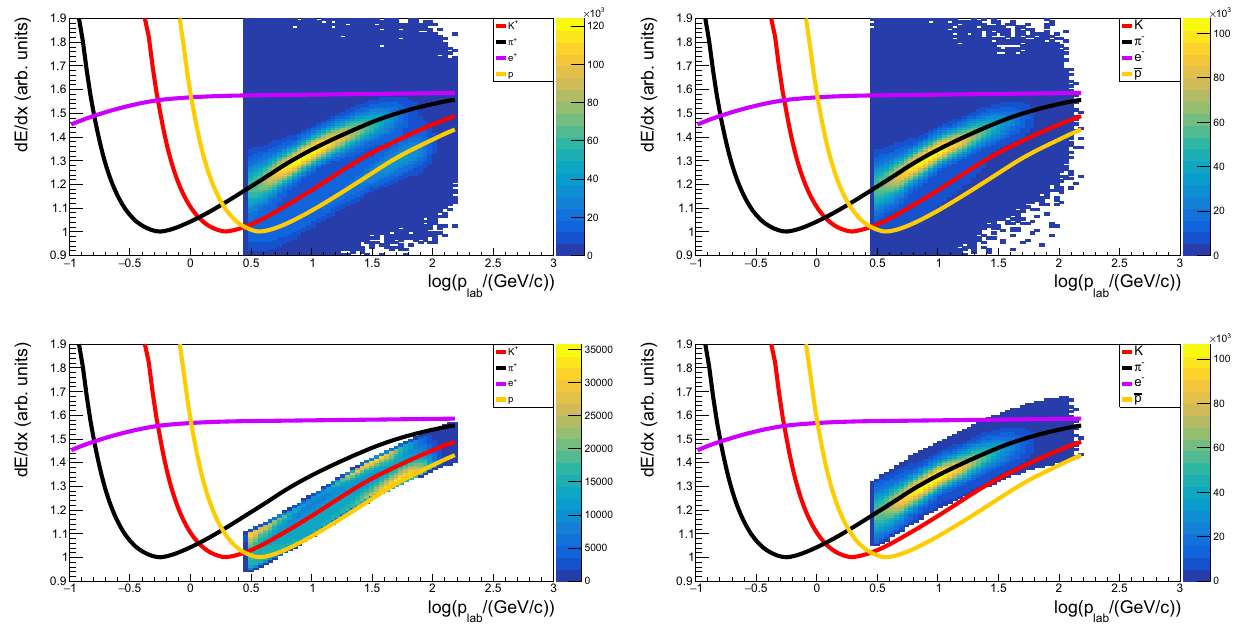
Fig. 3 Top: the values of d E / d x versus log ( p lab /( GeV / c )) for positively (left) and negatively (right) charged particles after track cuts (i)–(vi) from Sect. 3.4. The Bethe–Bloch curves are also drawn. Bottom: selection of K + (left) and π − (right)